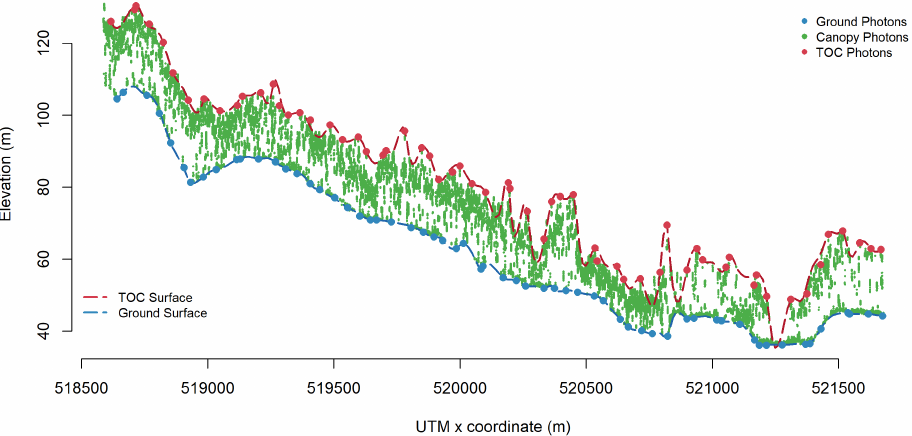
Figure 6. The result of ground and canopy surface extraction in Howland research forest.